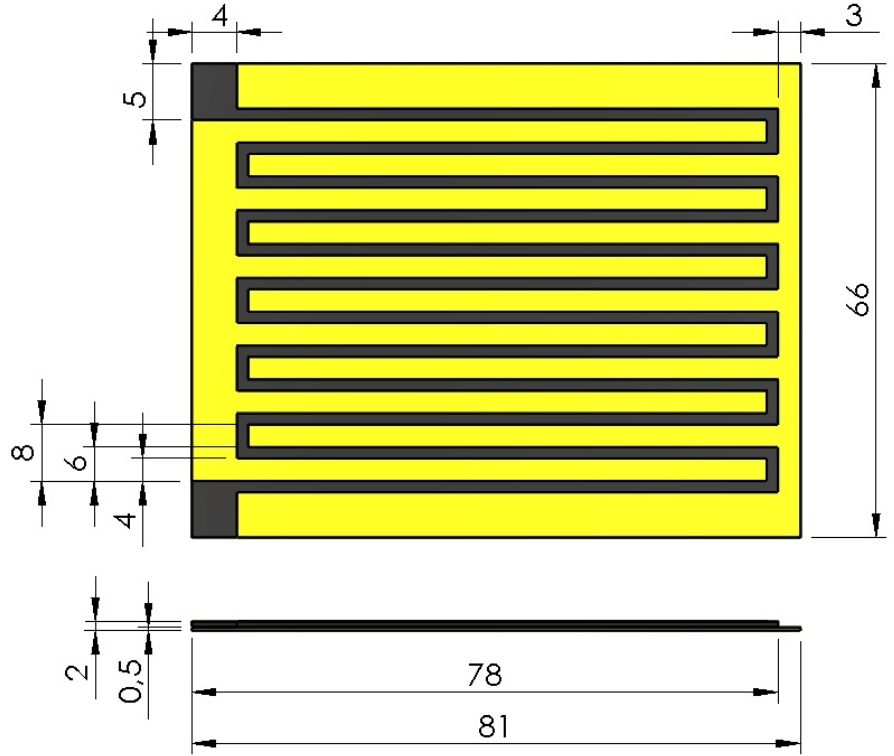
Figure 1. The design of the 3D-printed strain sensor with flexible UV resin body (yellow) and conductive UV Resin tracks (black).